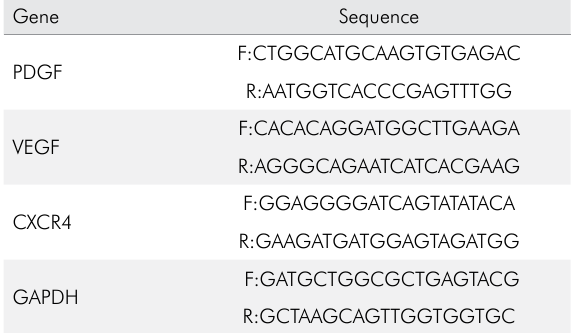
Table. Primer sequences for